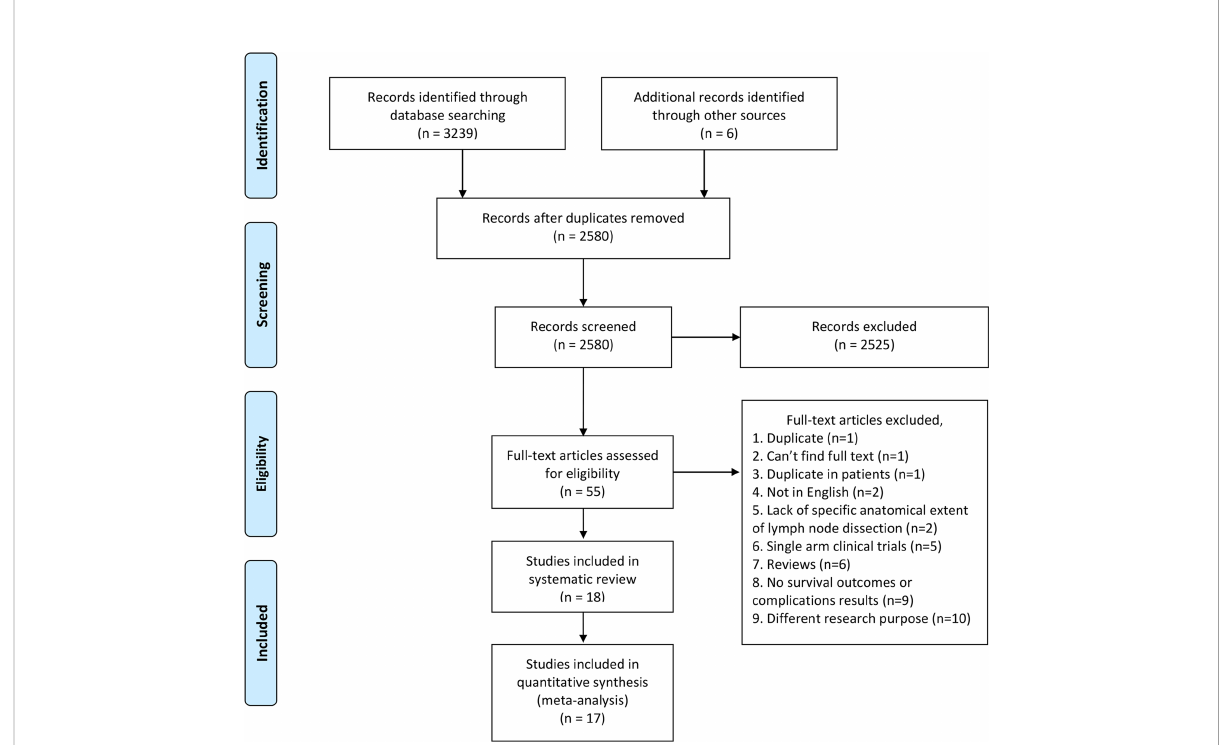
FIGURE 1 PRISMA fl ow diagram of literature retrieval. PRISMA, Preferred Reporting Items for Systematic Reviews and